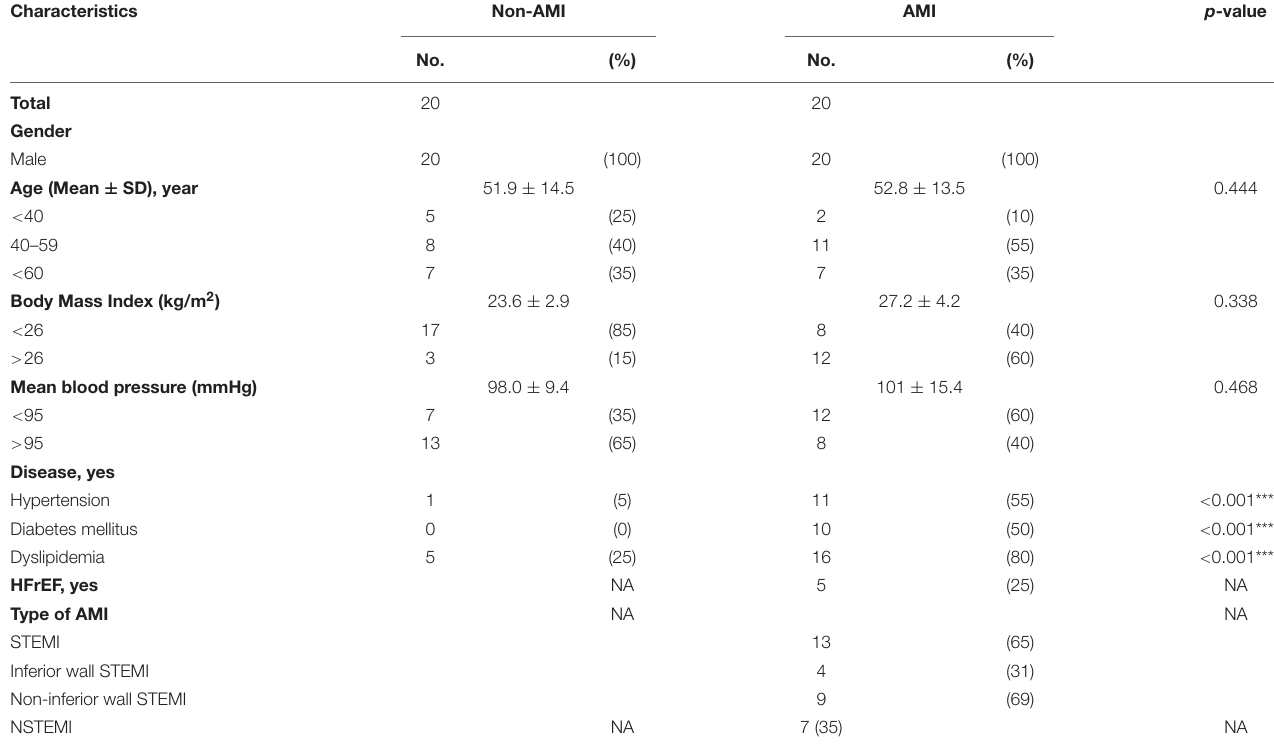
TABLE 1 | Comparison of clinical characteristics of study